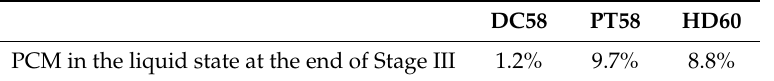
Table 12. Percentages of the PCMs that remain in the liquid state at the end of Stage III ( ˘ 1.0%).